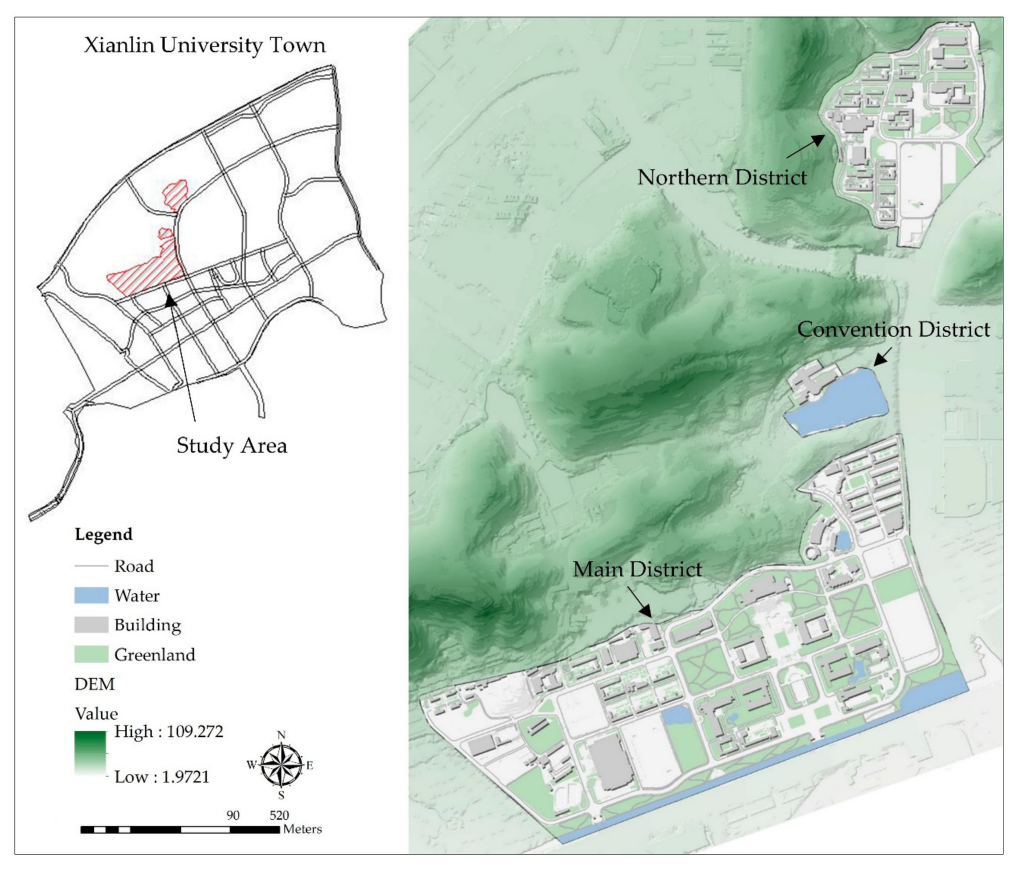
Figure 6. Location of the study area, which contains three separated sub-basins: the northern district, convention district, and main